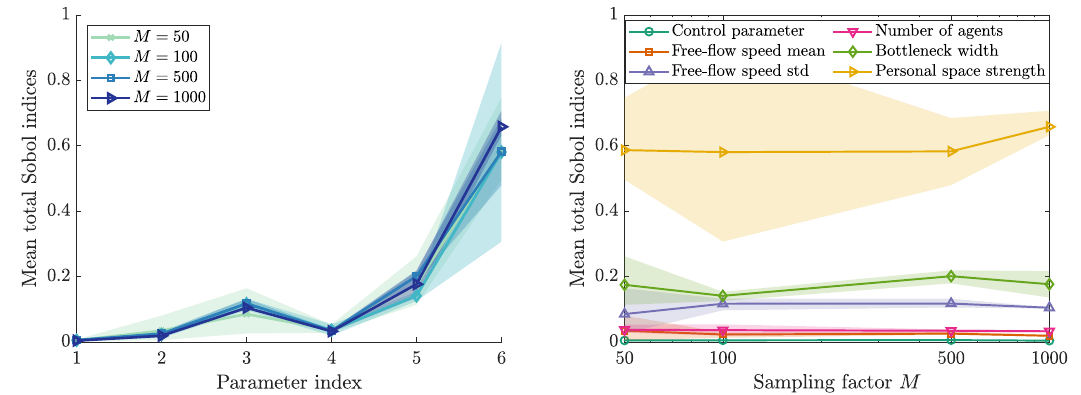
Figure 7. Normalized Sobol’ total indices for bottleneck scenario. Calculated with Monte Carlo approach while using Jansen’s method [53]. For each sampling factor M , three runs were performed. The parameter index is mapped as follows: 1—control parameter, 2—free-flow speed mean, 3—free-flow speed standard deviation, 4—number of agents, 5—bottleneck width, 6—personal space